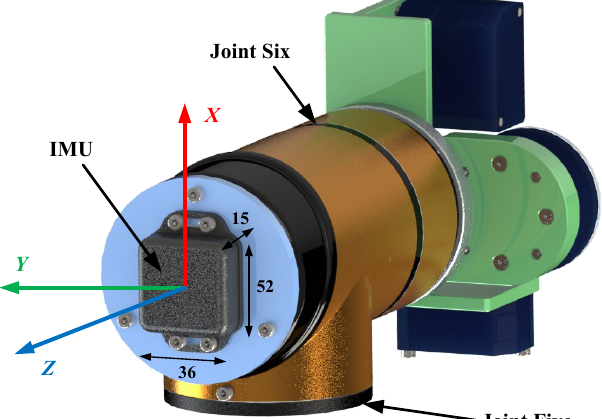
Figure 4. Rendering of the Bluetooth sensor mounting position. The sensor is mounted vertically on the motor cover at the robotic arm’s end near joint five. The three directions of the measurement axes are shown. In addition, the core dimensions of the sensor are marked (mm).